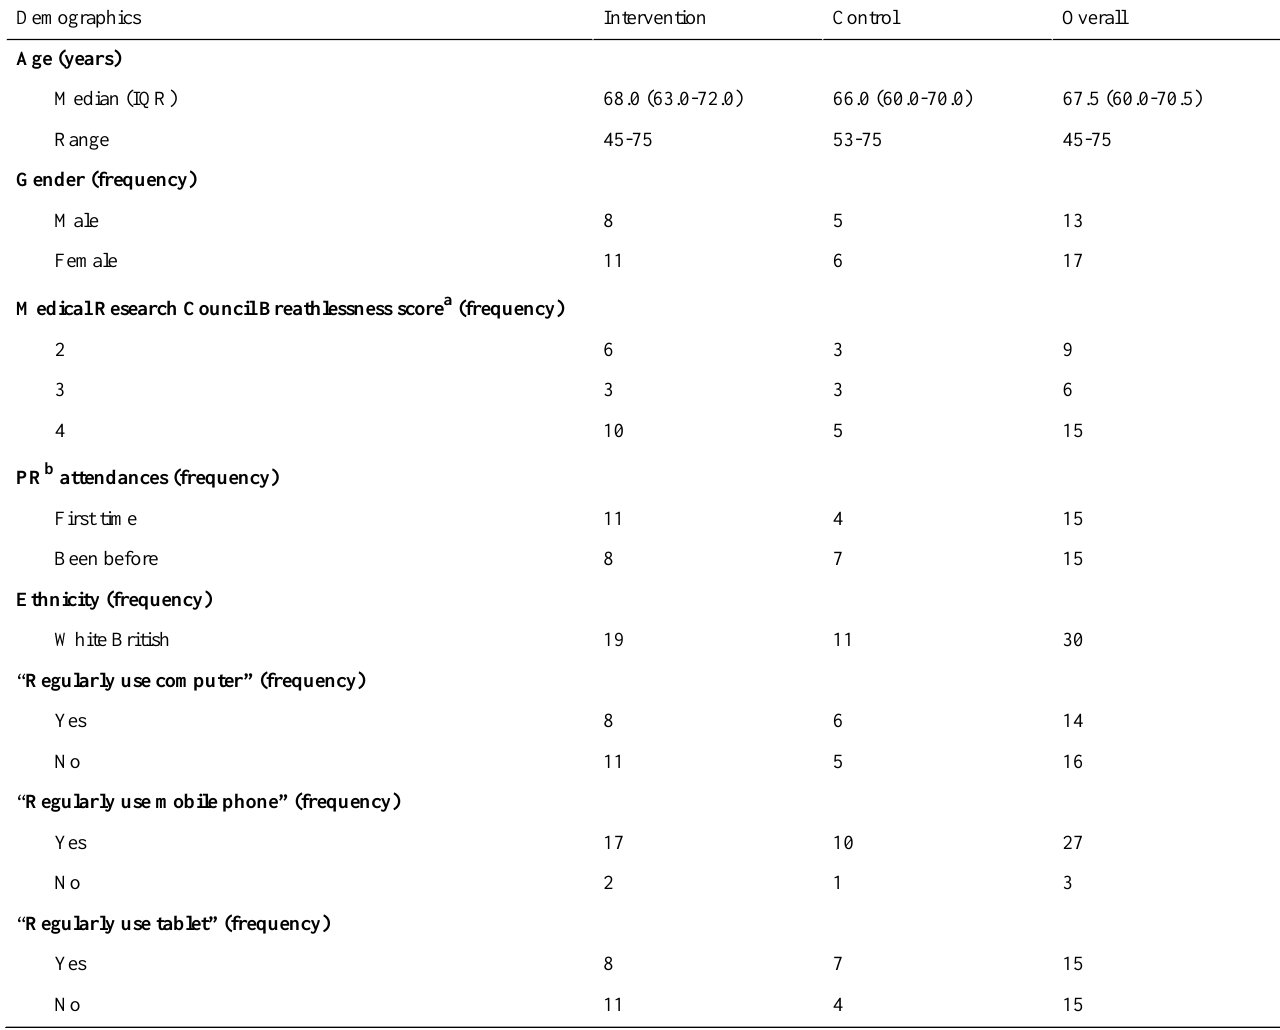
Table 3. Summary of participants’baseline demographics and